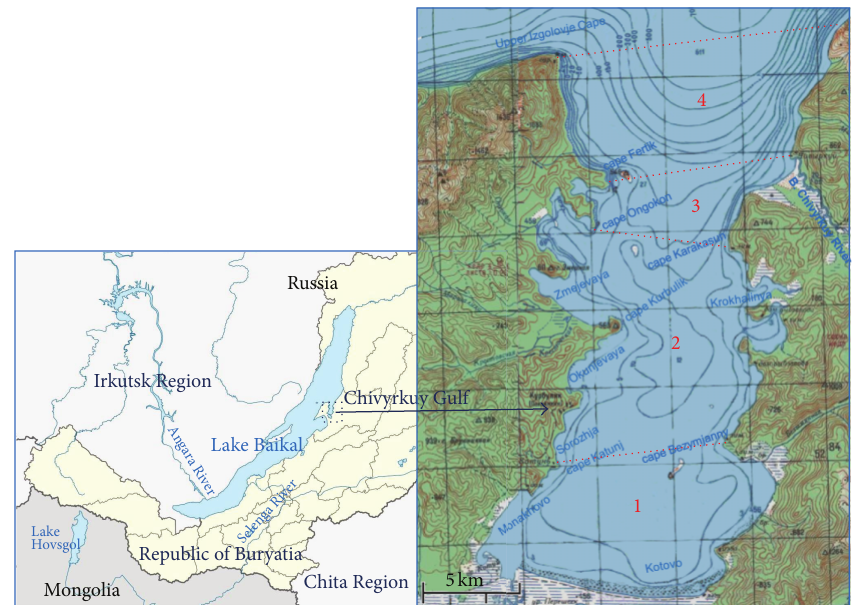
Figure 1: Geographical location of the study region with bathymetric data and indication of main bays and capes. Dotted lines divide different bioproductivity zones: 1: eutrophic zone, 2: mesotrophic zone, 3: oligotrophic zone, and 4: ultraoligotrophic